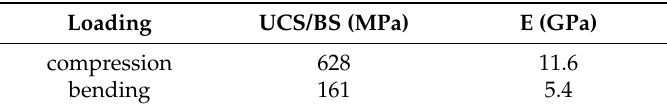
Figure 7. Fractured sample after the bending test: ( a ) plasma-sprayed Ti and ( b ) Ti wire .